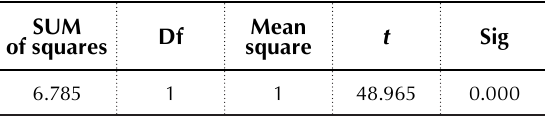
Table 9. Variance analysis, t -test for the forth hypothesis SUM of squares